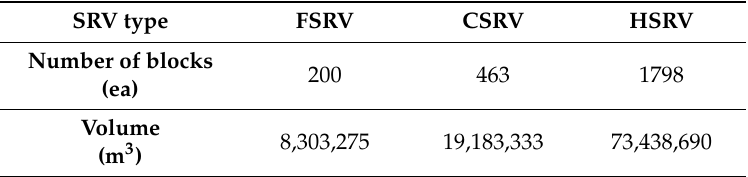
Table 2. Stimulated reservoir volume (SRV) information.